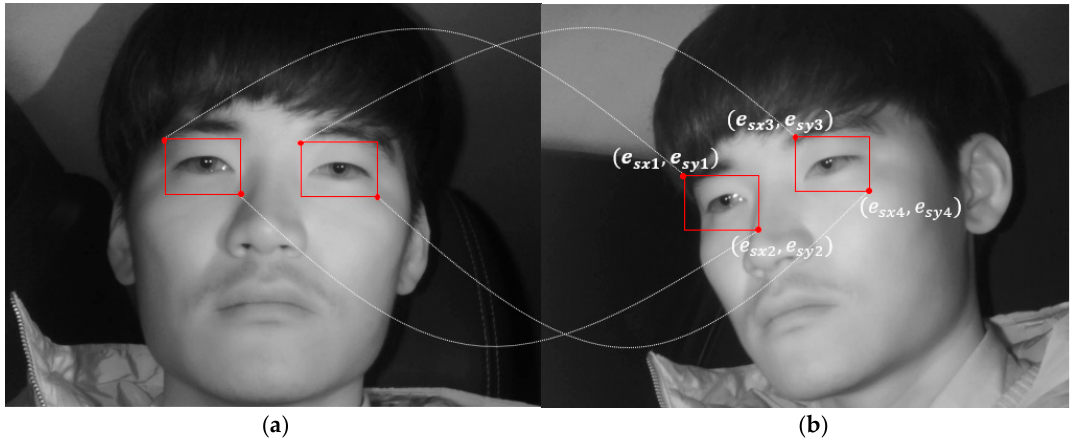
Figure 9. Mapping of eye regions in side face image. ( a ) Detecting eyes in frontal face image using faster R-CNN; ( b ) Mapping of eye regions in side face image using geometric transform.